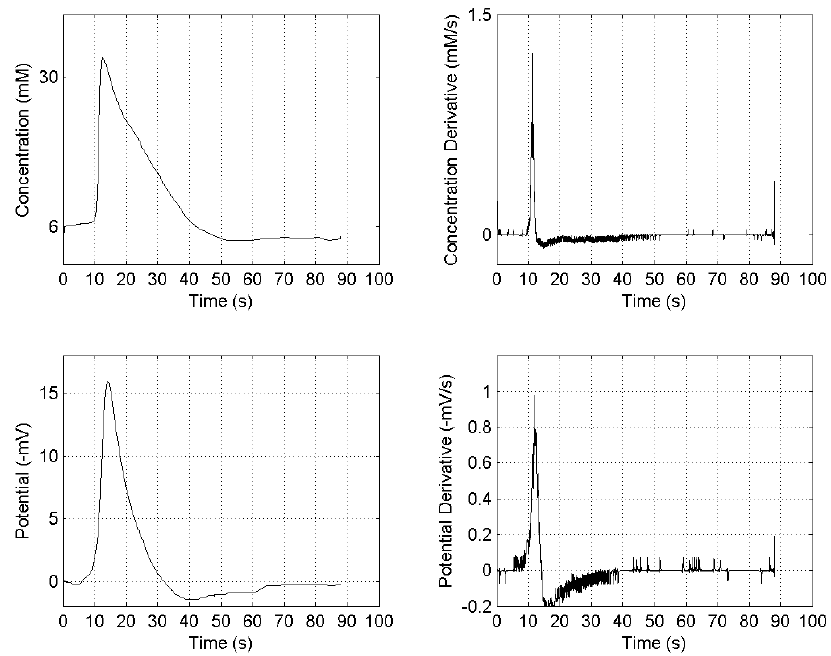
Fig. 1 – Typical record of electrophysiological wave concomitants at the inner plexiform layer of chick retina. Upper row: Extra-cellular potassium activity and its derivative. Lower row: Extra-cellular potential and its